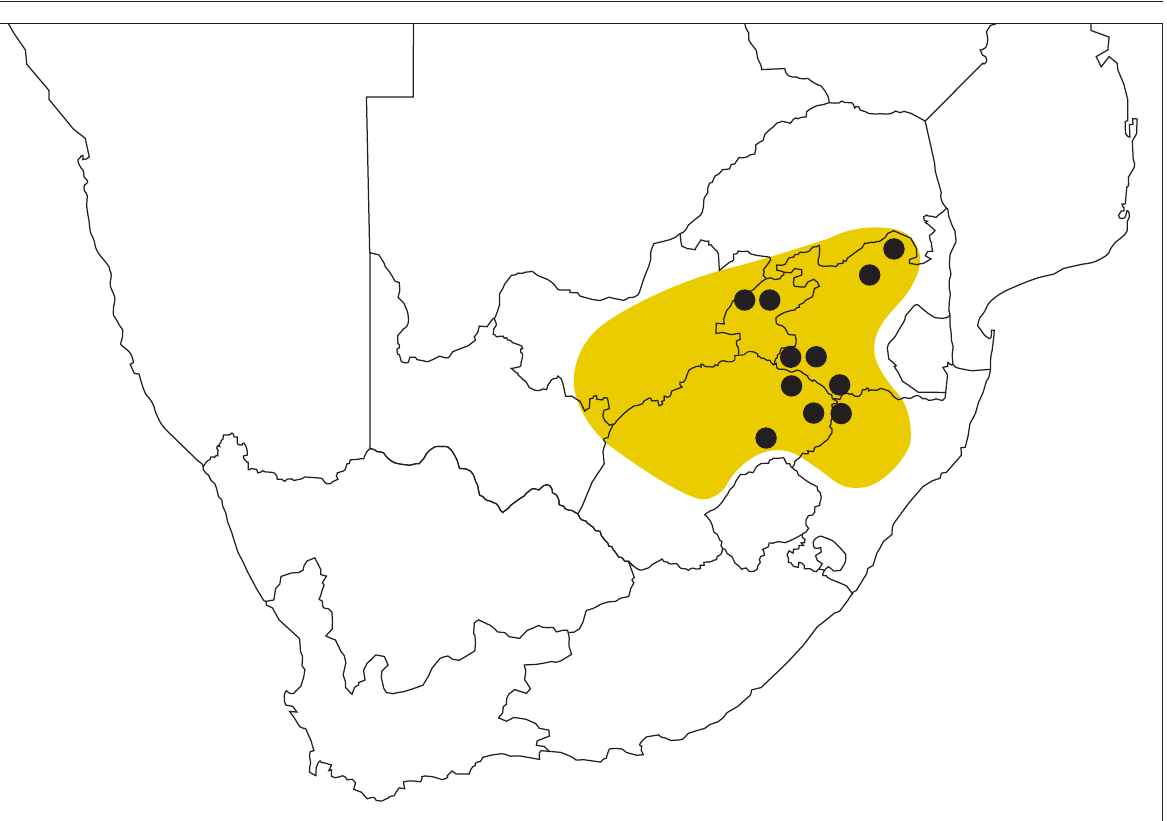
FIG. 11 The distribution of Claviceps cyperi in relation to the main maize producing area of South